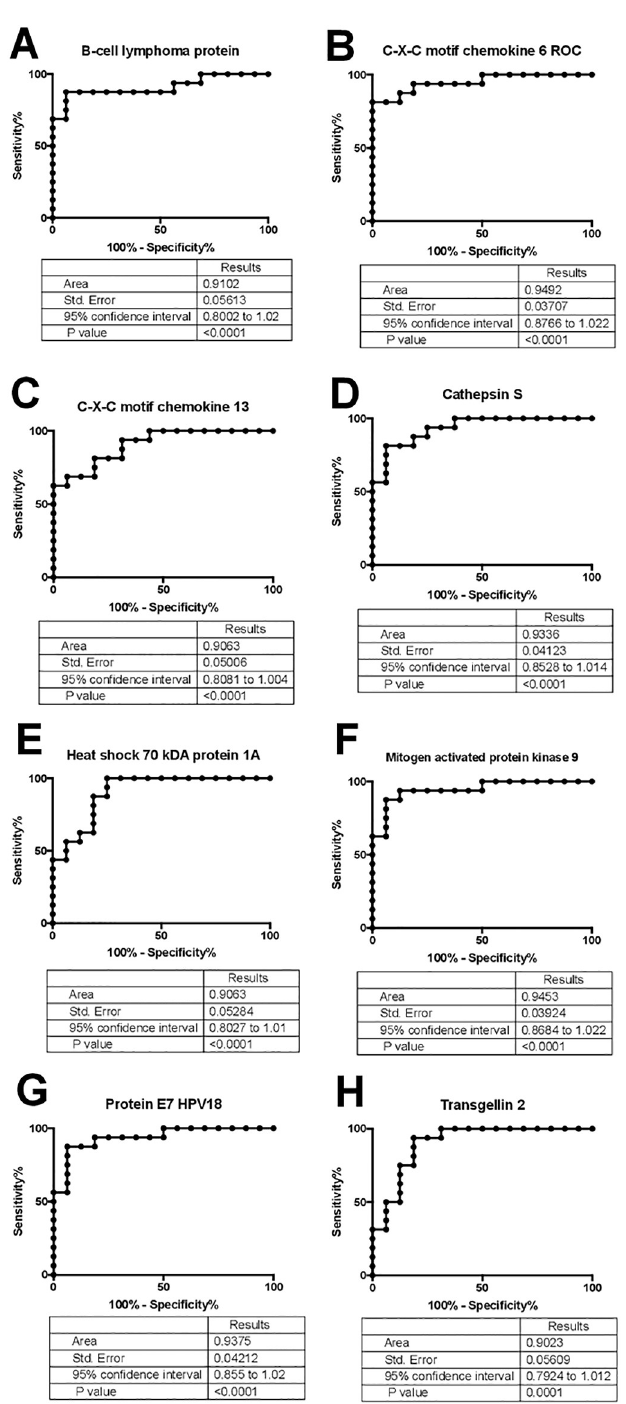
Fig 1. Candidate biomarker ROCs: Area under the curve (AUCs) demonstrating the 8 candidate biomarkers that meet p value filtering criteria and had AUCs > 0.9. B-cell lymphoma protein ( A ), C-X-C motif chemokine 6 ( B ) C-X-C motif chemokine 13 ( C ), Cathepsin S ( D ), Heat shock 79kDA protein 1A ( E ), Mitogen activated protein kinase ( F ), Protein E7 HPV18 ( G ) and Transgelin 2 ( H ) are presented.